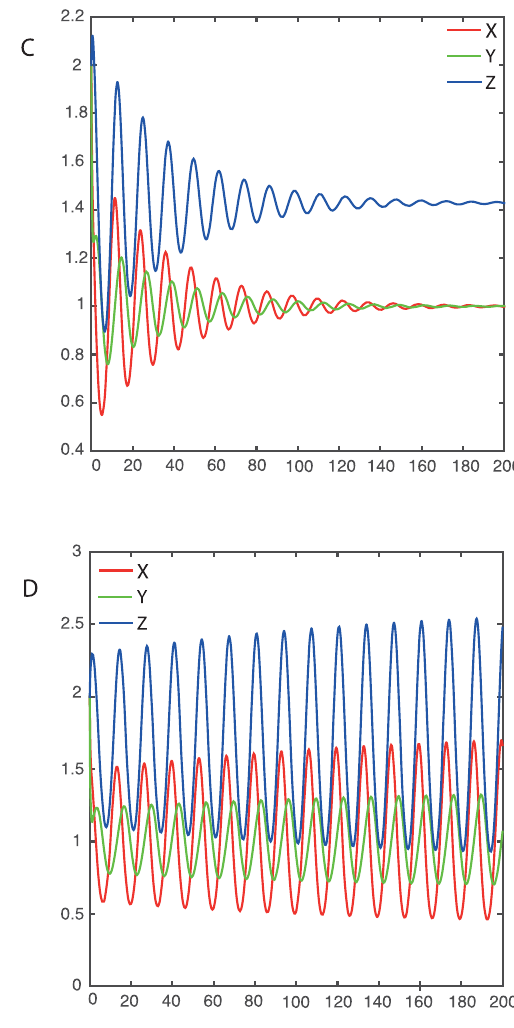
Figure 4. Phase space plots obtained by solving numerically the differential equations of the Coimbrator. ( A ) Dynamics with α = 1 and β = 0.7 make the system evolve to equilibrium, and ( C ) corresponding damped oscillations of the xyz variables. ( B ) Dynamics with α = 1 and β = 0.6 lead to a periodic orbit and ( D ) corresponding sustained oscillations of the xyz